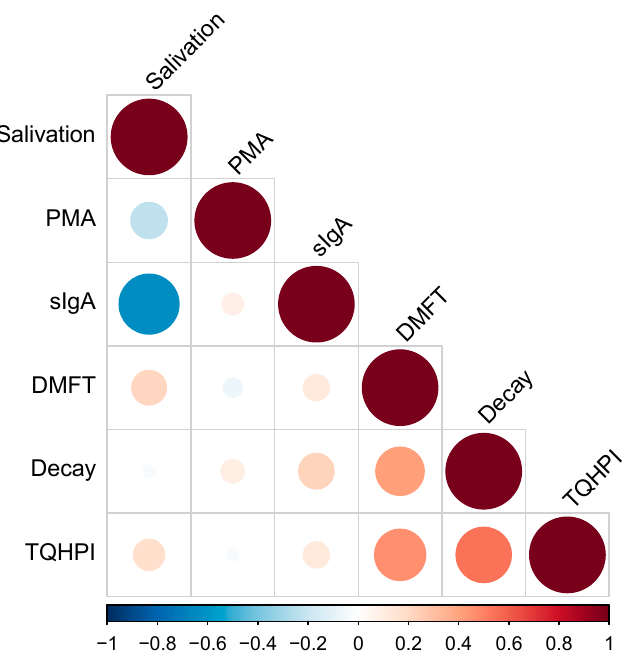
Figure 2. Correlation analysis. TQHPI—Turesky modification of the Quigley-Hein plaque index; DMFT—decayed, missing, and filled teeth index; sIgA—secretory immunoglobulin A; PMA—papillary marginal attached index.